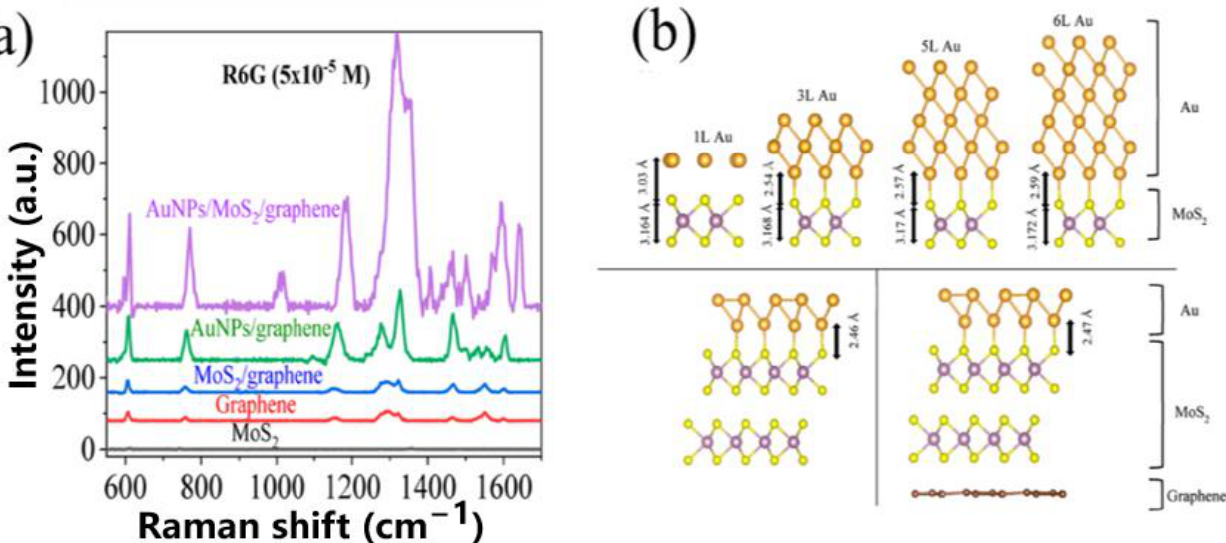
Figure 12. ( a ) R6G Raman spectra of 5 × 10 −5 M concentration with different substrates: AuNPs/MoS 2 /graphene (purple), AuNPs/graphene (green), MoS 2 /graphene (blue), graphene (red), and MoS 2 (black). ( b ) ( top ) Atomic layer stacks of Au/MoS 2 , hybrid heterostructures with different numbers of Au layers of 1L, 3L, 5L and 6L on monolayer MoS 2 .The interface distance between the two materials is also illustrated. The atomic layer stacks of 2L Au/2L MoS 2 : hybrid het- erostructures ( left - bottom ) without graphene layer and ( left - bottom ) with graphene layer. Reprinted from Ref. [125] with permission of 2019 American Chemical